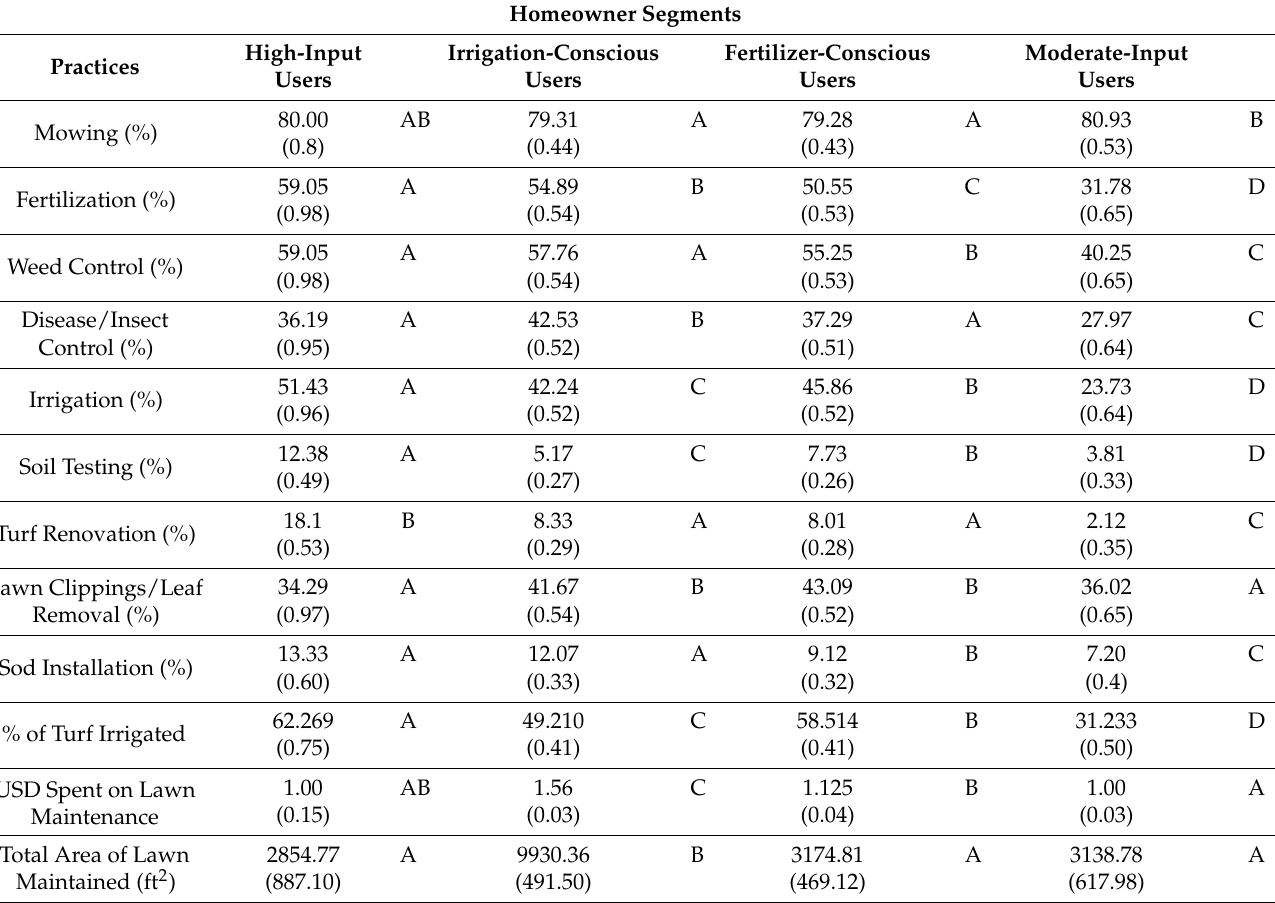
Table 5. Pairwise mean comparison of lawn care practices for the four classes of users. Homeowner